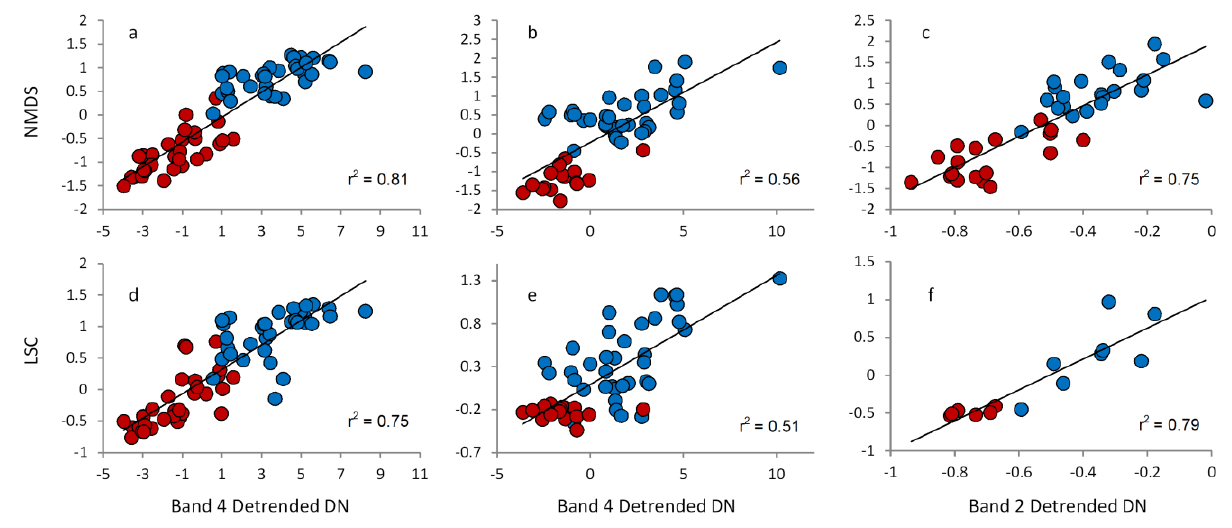
Figure 2. Scatterplots for selected regressions in Tables 1 and 2. Plots depict the relationship between either detrended band 4 or detrended band 2 of Landsat data (measured by detrended digital numbers, ‘DN’), and either the main floristic gradient (measured by a single nonmetric multidimensional scaling axis; ‘NMDS’) or the soil cation gradient (measured as the log-transformed sum of the concentrations of Ca, Mg, Na, K; ‘LSC’), for three study areas in northern Peru. Points represent individual sites, and are colored according to clustering memberships in Figure 1. ( a ) and ( d ) Pastaza-Tigre study area. ( b ) and ( e ) Curaray study area. ( c ) and ( f ) Sucusari study area. (a–c) Correspond to results from Table 1. (d–f) Correspond to results from Table 2. R 2 values for each regression are indicated in the bottom-right of each